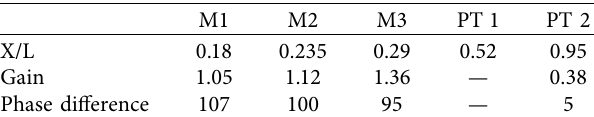
Figure 9: Results of pressure mode shape reconstruction for mixing tube (a) and combustor (b) in no PIM case. Table 1: Location, gain, and phase difference at each measurement location for no PIM